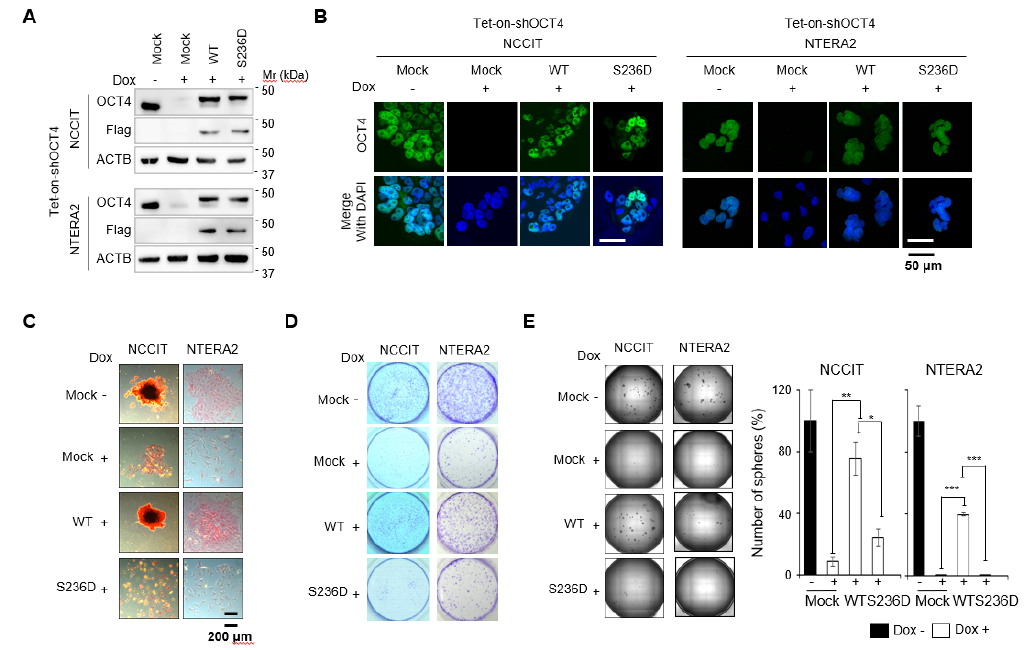
Figure 2. Replacement of endogenous OCT4 with a mimic of p-OCT4 (S236) causes a phenotype similar to OCT4 depletion in GCTs. ( A ) Generation of cancer cell lines expressing Flag-tagged WT and phospho-mimetic mutant OCT4 instead of endogenous OCT4. NCCIT and NTERA-2 cells stably incorporating Tet-on-shOCT4 were then stably incorporated with a WT and a phospho-mimetic (S236D) OCT4 expression vector. The stable incorporation of the empty vector (Mock) was used as the control. After treatment with Dox (1 µg/mL) for four days for NCCIT and seven days for NTERA- 2, knockdown of endogenous OCT4 and rescue with OCT4 WT and S236D were confirmed by